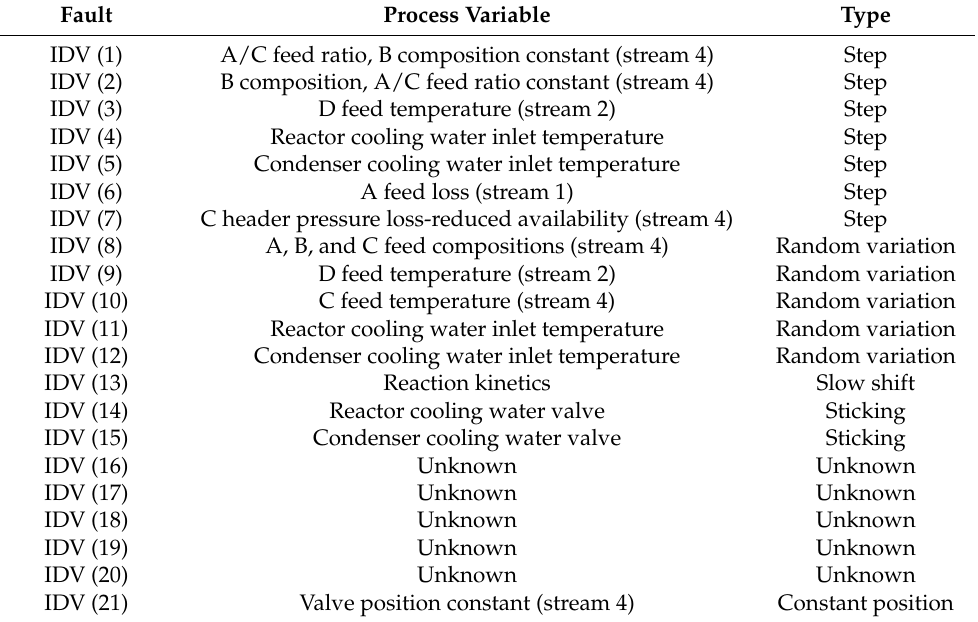
Table 2. Process faults for Tennessee Eastman process. Reprinted with permission from ref.